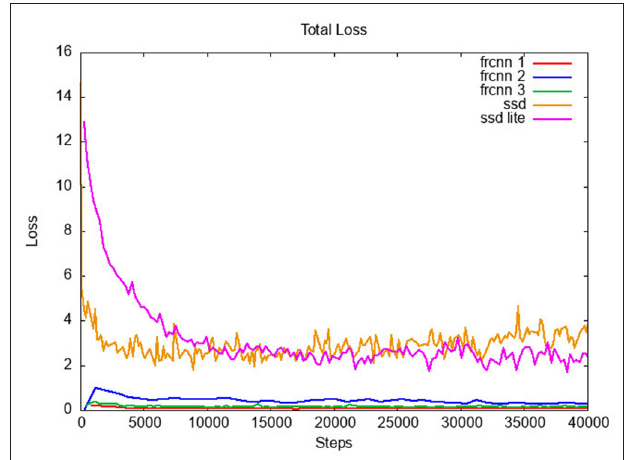
FIGURE 3 | Loss function for all networks, in relation to training